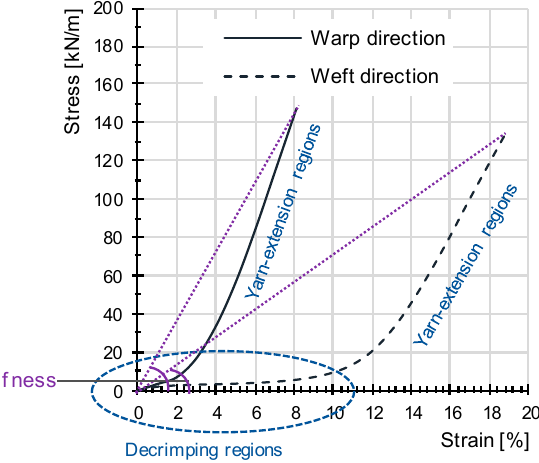
Figure 4. Stress–strain curves of a uniaxial tensile test, glass-PTFE type II, first batch (see Table 3).